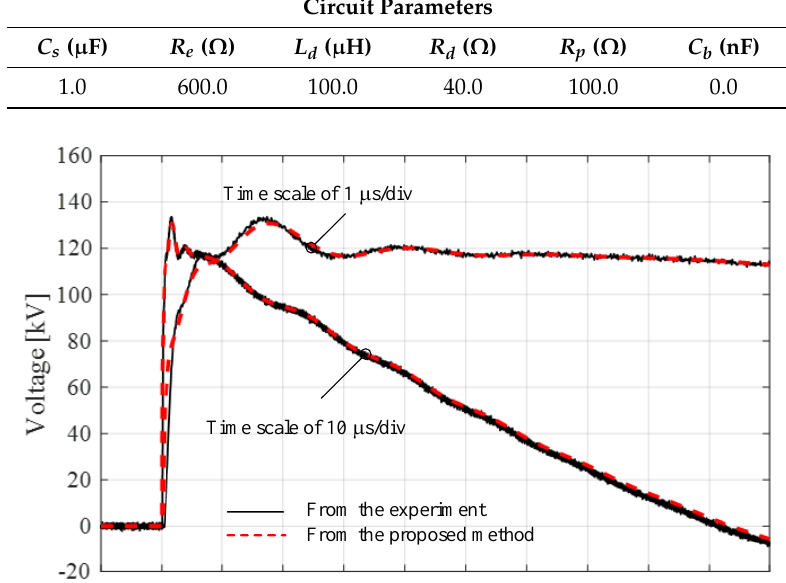
Figure 19. Comparison of the generated impulse voltage waveforms collected from the experiment and computed by the proposed method.